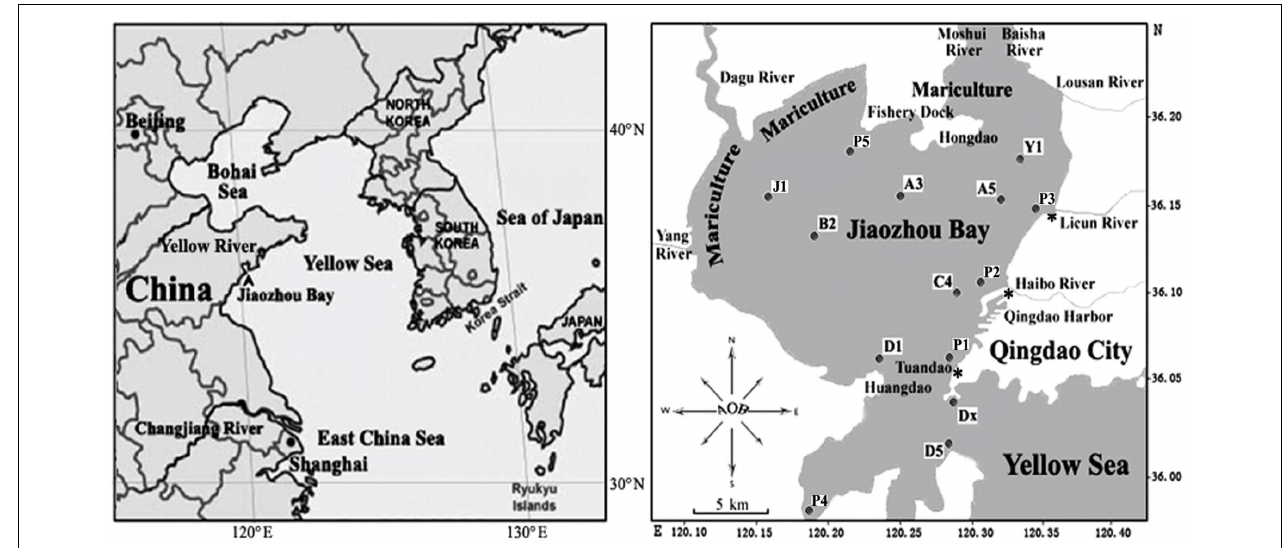
FIGURE 1 | Map of Jiaozhou Bay and sampling stations.